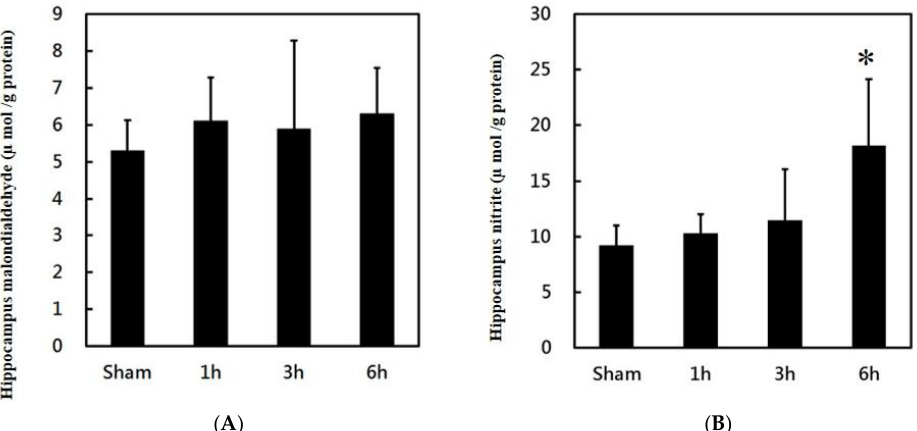
Figure 6. Effects of PPTg DBS on hippocampal oxidative stress: ( A ) illustration of oxidative stress marker malondialdehyde (MDA) and ( B ) illustration of nitrite levels in hippocampal tissue was determined at hours 1, 3, and 6-time intervals. Data were presented as mean ± SD ( n = 6). Significant di ff erences between groups were analyzed using one-way ANOVA. * p < 0.05 was considered statistically significant compared with the sham group.